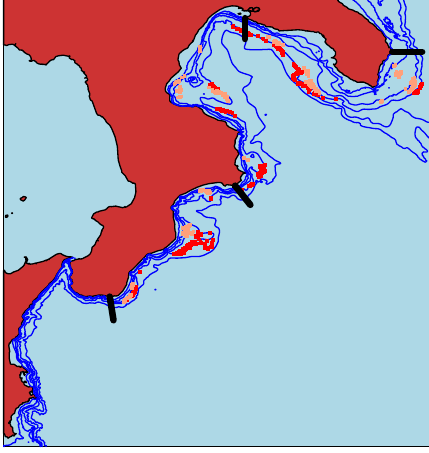
Figure 1 – Map of the study region divided into three sub-areas with bathyal curves and haul locations ( P. longirostris in pink, A. foliacea in